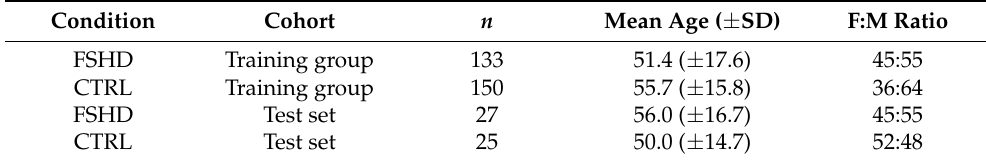
Table 1. Descriptive statistics of cohorts’